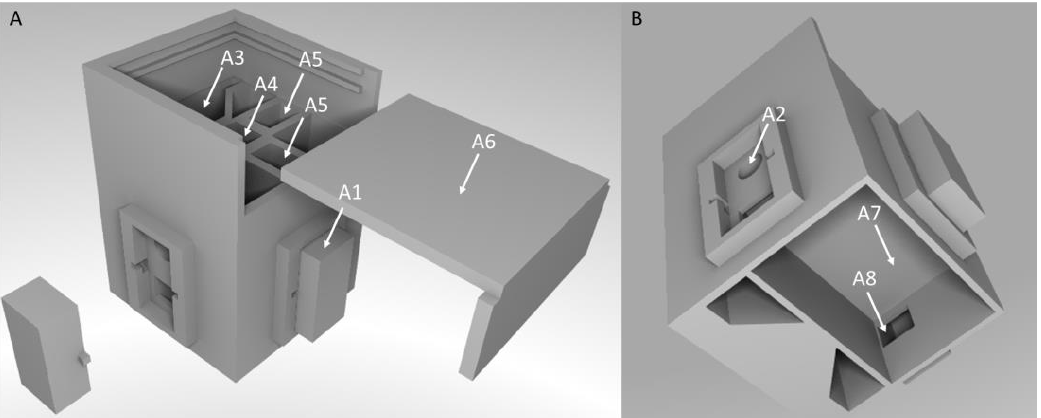
Figure 2. CAD-model of the developed measuring chamber of the portable photo- and fluorimeter. ( A ) = Front view of the measuring chamber of the developed photo- and fluorimeter, ( B ) = Bottom view of the measuring chamber. A1 = Cover for LED-inserts, A2 = LED insert and cutout for LED- wiring, A3 = Place for a LED board, A4 = place for a 4 mL cuvette, A5 = Pathway for light from LED to sample and from sample to phototransistor, A6 = Cover for measuring chamber, A7 = compartment for storing of the circuit board, A8 = Cutout for guiding the jumper cables from the LEDs and the phototransistor to the circuit